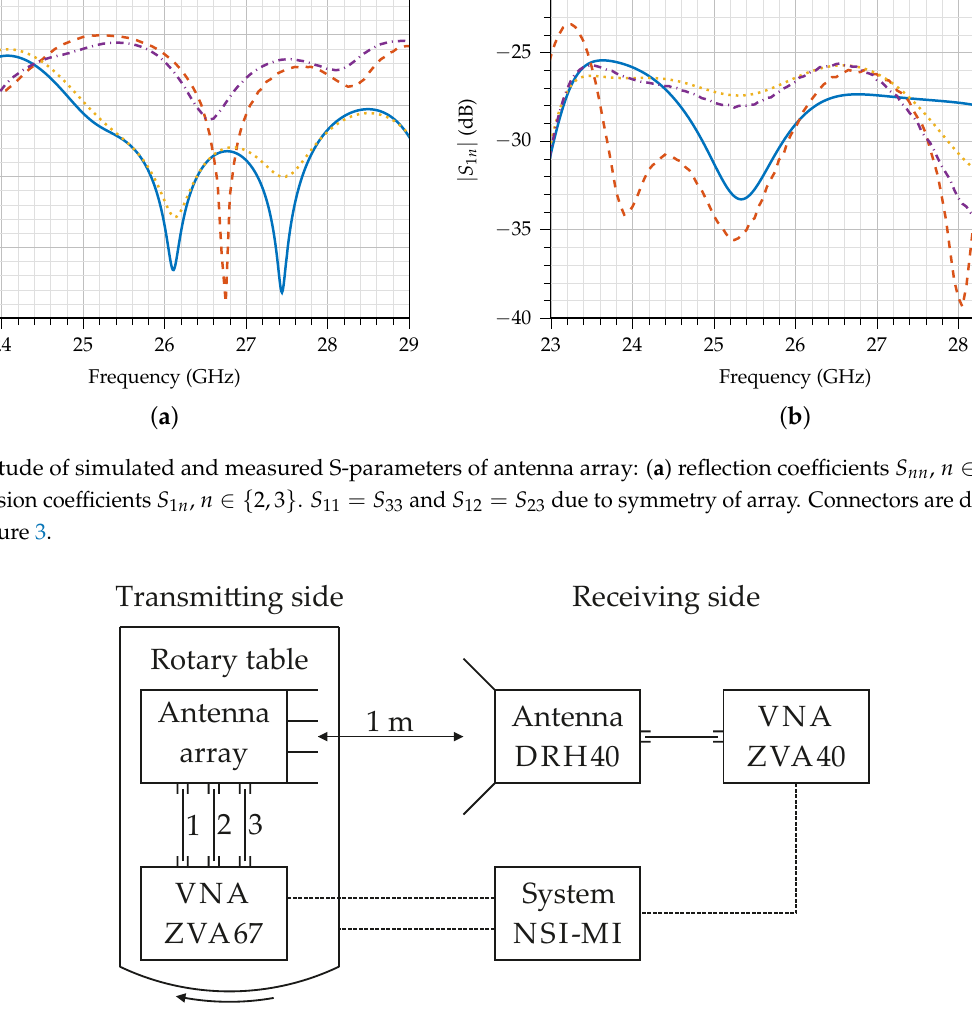
Figure 6. Setup for measurement of radiation